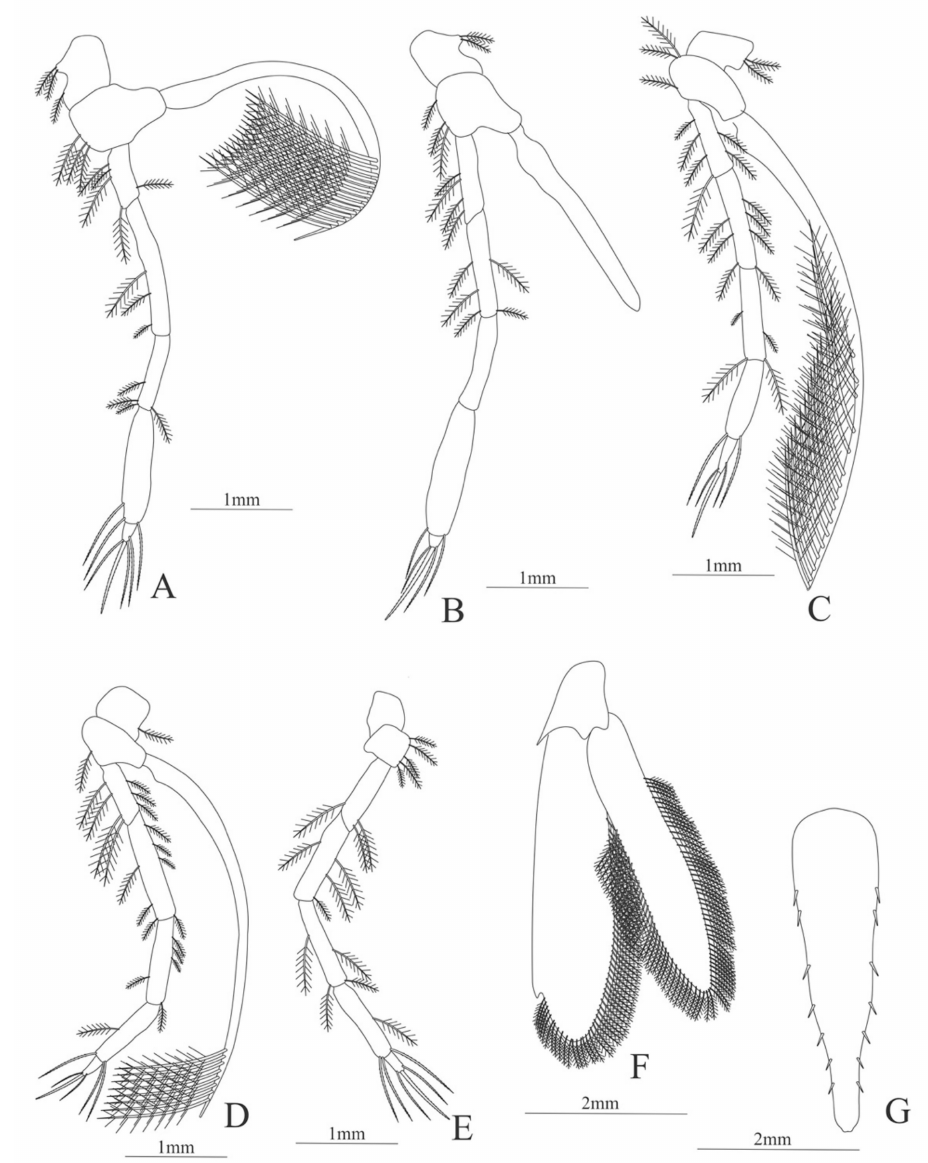
Figure 15. Nematocarcinus rotundus : ( A ) first pereopod; ( B ) second pereopod; ( C ) third pereopod; ( D ) fourth pereopod; ( E ) fifth pereopod; ( F ) uropods; ( G )